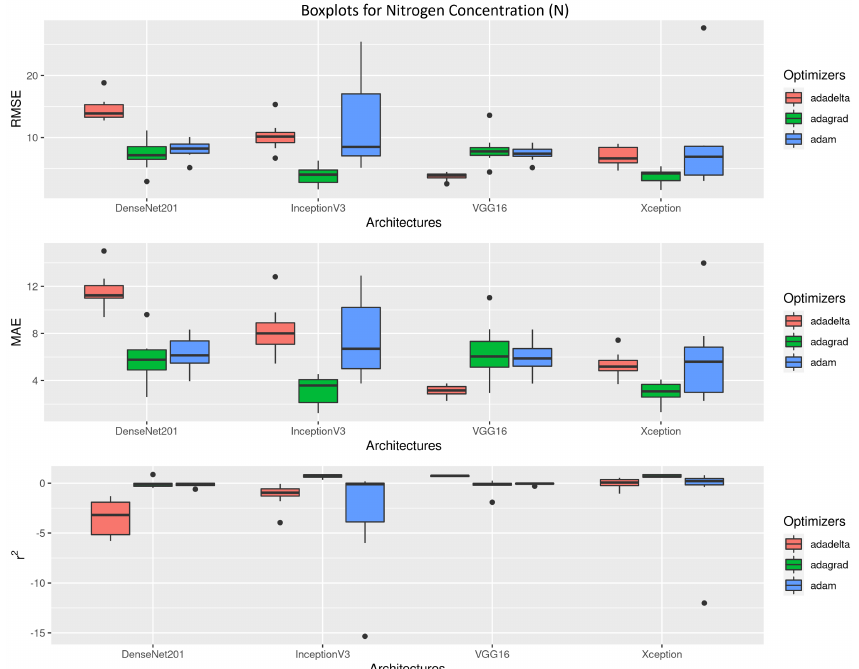
Figure 5. Nitrogen concentration root mean squared error (RMSE) (g N/kg DM), mean absolute error (MAE) (g N/kg DM) and coefficient of determination ( r 2 ) boxplots for all four architectures (DenseNet201, InceptionV3, VGG16 and Xception) and the three optimizers (Adadelta, Adagrad and Adam) used. The data came from the 8 runs (i.e., 8 cross-validation folds) of each configuration (architecture+optimizer) over the N test set.